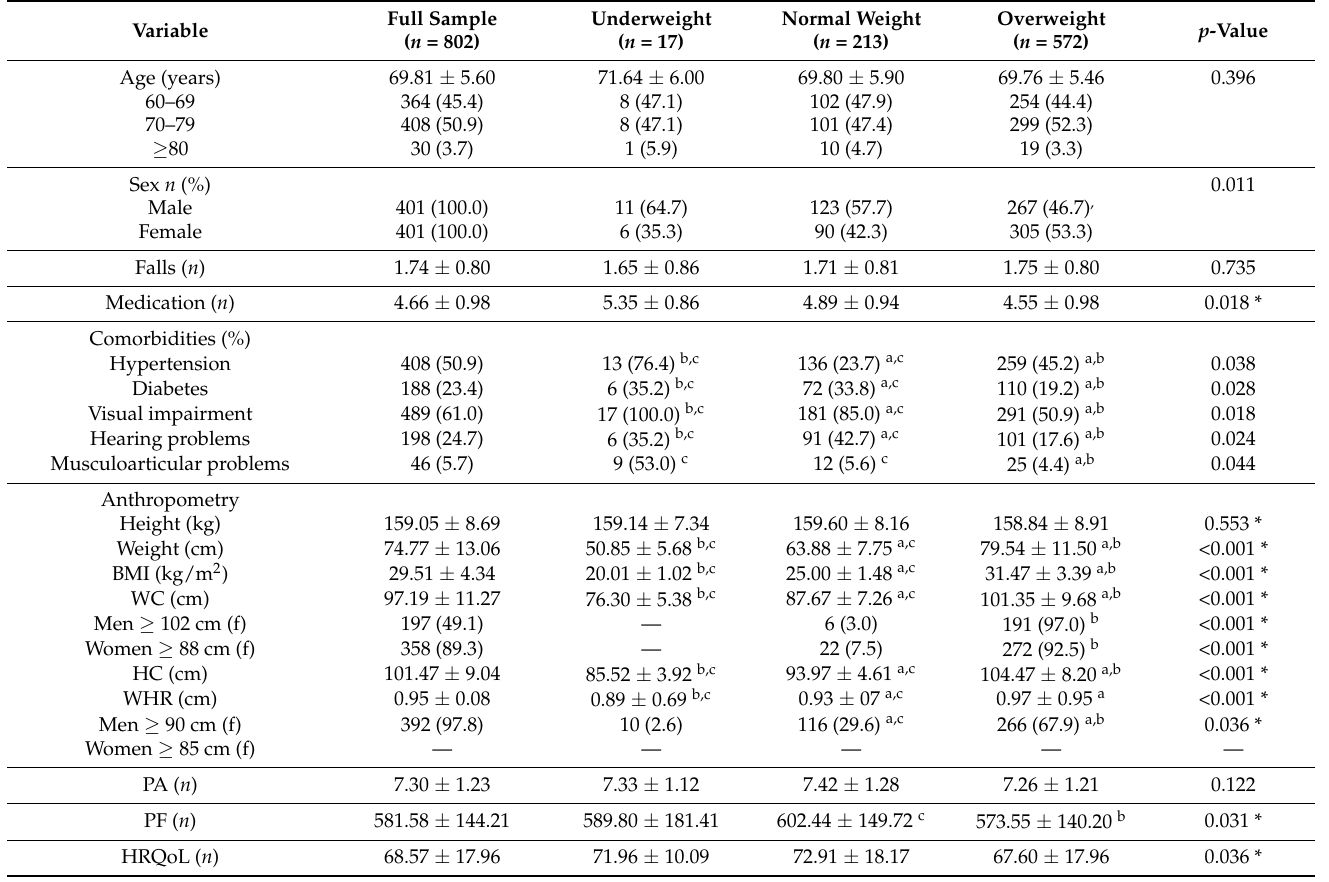
Table 1. Main characteristics of the